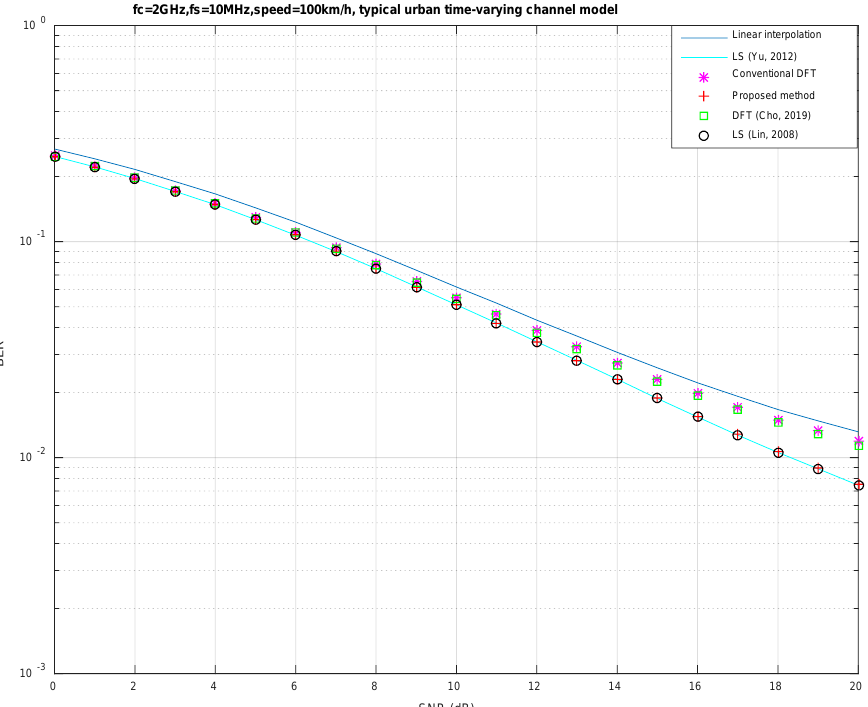
Figure 3. Simulated diagram of SNR to error rate when the carrier frequency is 2 GHz, the sampling frequency is 10 MHz, and the speed is 100 km/h for the typical urban time-varying channel model [8,10,11].